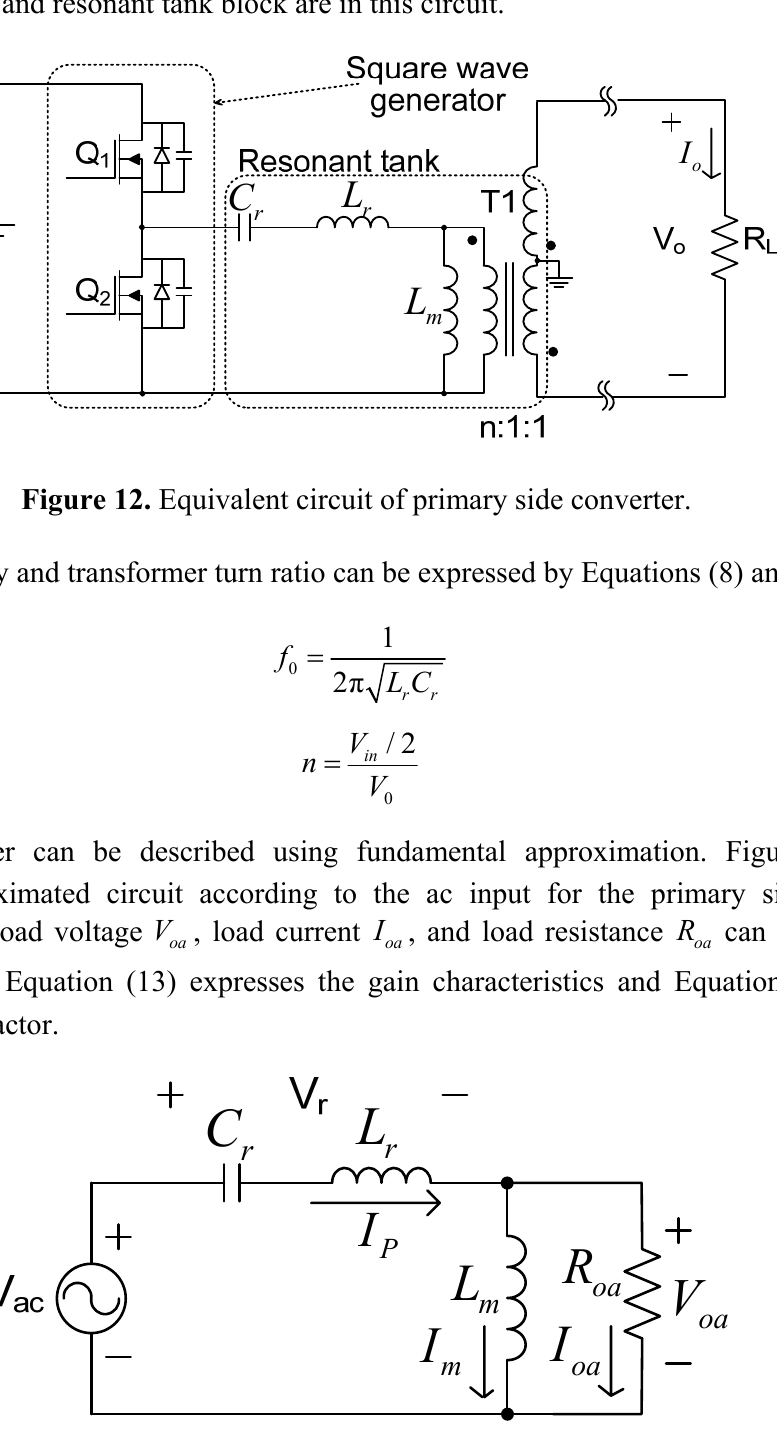
Figure 13. Fundamental approximated circuit of primary